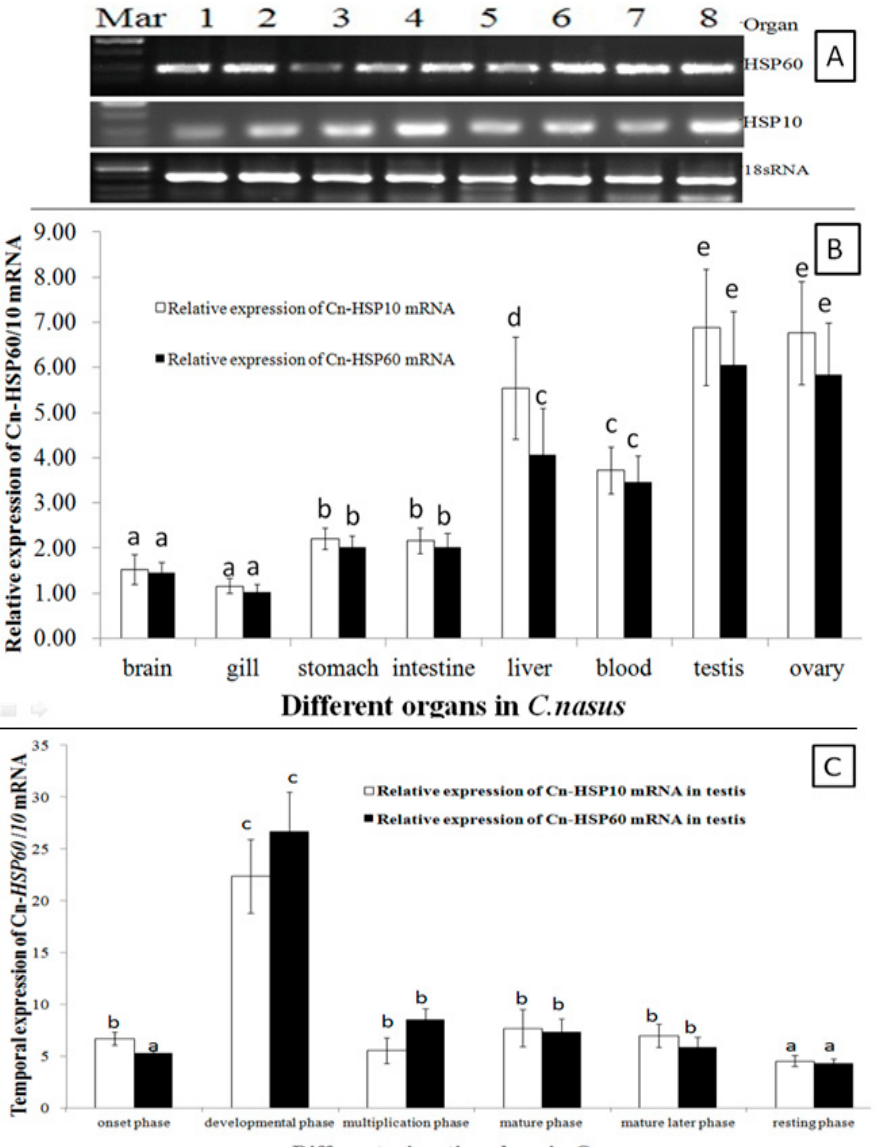
Figure 3. HSP60 and HSP10 mRNA Expression Patterns. ( A , B ) are for different organs by RT-PCR and RT-qPCR method, respectively; ( C ) is for different migration phase. Data were expressed as the mean fold difference (mean ± SE, pooled RNA, n = 6, one in each section, total n = 3 × 6 = 18). Expression values were normalized to those of 18sRNA. Values with the different superscript letters are significantly different ( p < 0.05, a < b < c < d < e). In ( A ), Mar: molecular marker, 1: blood, 2: brain,